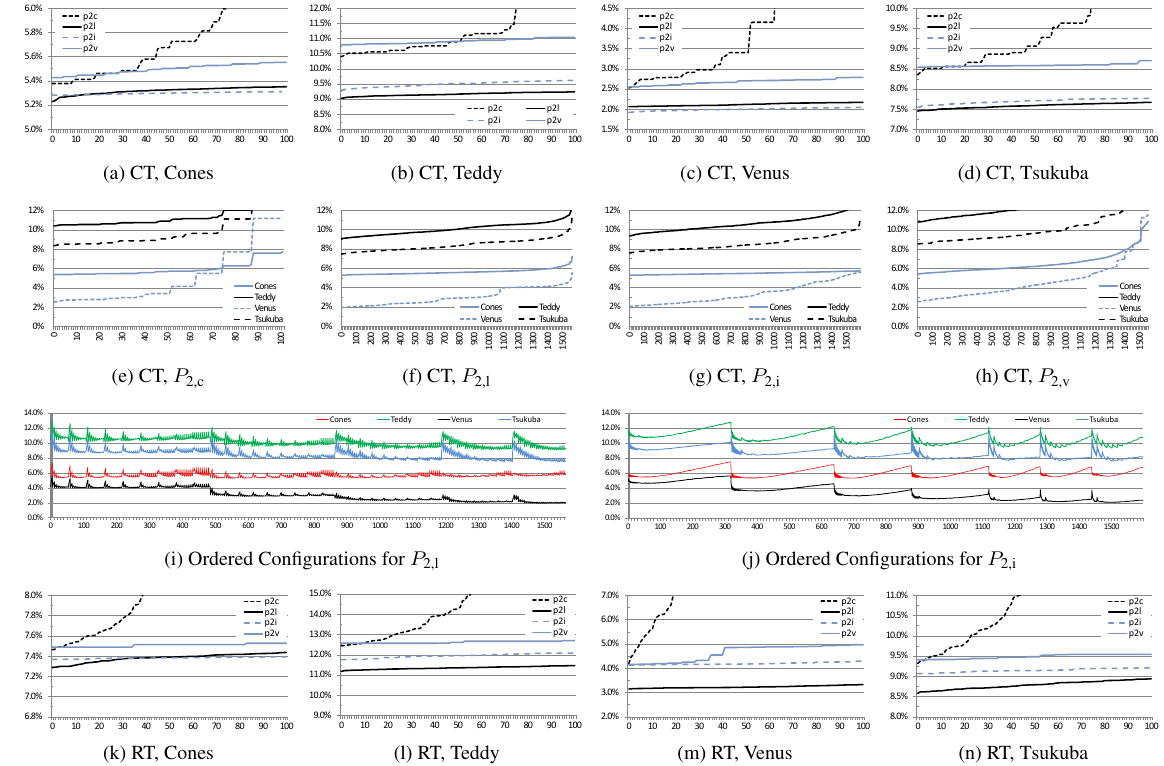
Figure 4: Errors in unoccluded areas for all penalty functions employing census transform examining behavior on the same image (row one), over different images (row two), stability of configurations across images (row three), and employing rank transform (row four).